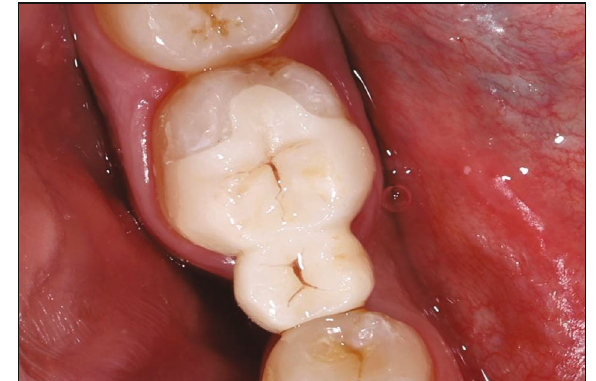
Figure 8: Occlusal view of resin-bonded inlay-retained cantilever fi xed dental prosthesis immediately after